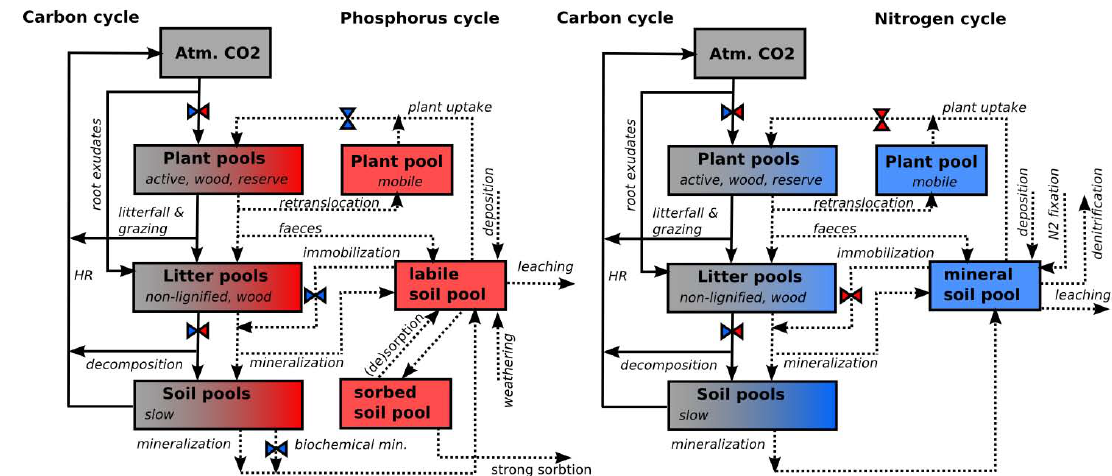
Fig. 1. Schematic representation of pools and fluxes in JSBACH. Solid arrows indicate carbon fluxes and dashed arrows nutrient fluxes. The plant compartment consists of the three C pools: active (leaves and non-lignified tissue), wood (stem and branches) and reserve (sugar and starches). The litter compartment consists of non-lignified litter, and woody litter (lignified litter and fast-decomposing soil organic matter). The soil compartment consists of one pool (slow) representing slow-decomposing organic matter. All carbon pools except the reserve pool have a corresponding nutrient pool with variable C:N:P ratio (slow, non-lignified litter) or fixed C:N:P ratio (rest). There is one mobile plant pool representing mobile nutrients stored internally in plants. Soil mineral nitrogen is represented by a single pool (soil mineral pool), while mineral P is represented by labile (available) pool and sorbed pool. The opposing triangles indicated that the flux is controlled by phosphorus (red triangles), nitrogen (blue triangles) or both (mixed